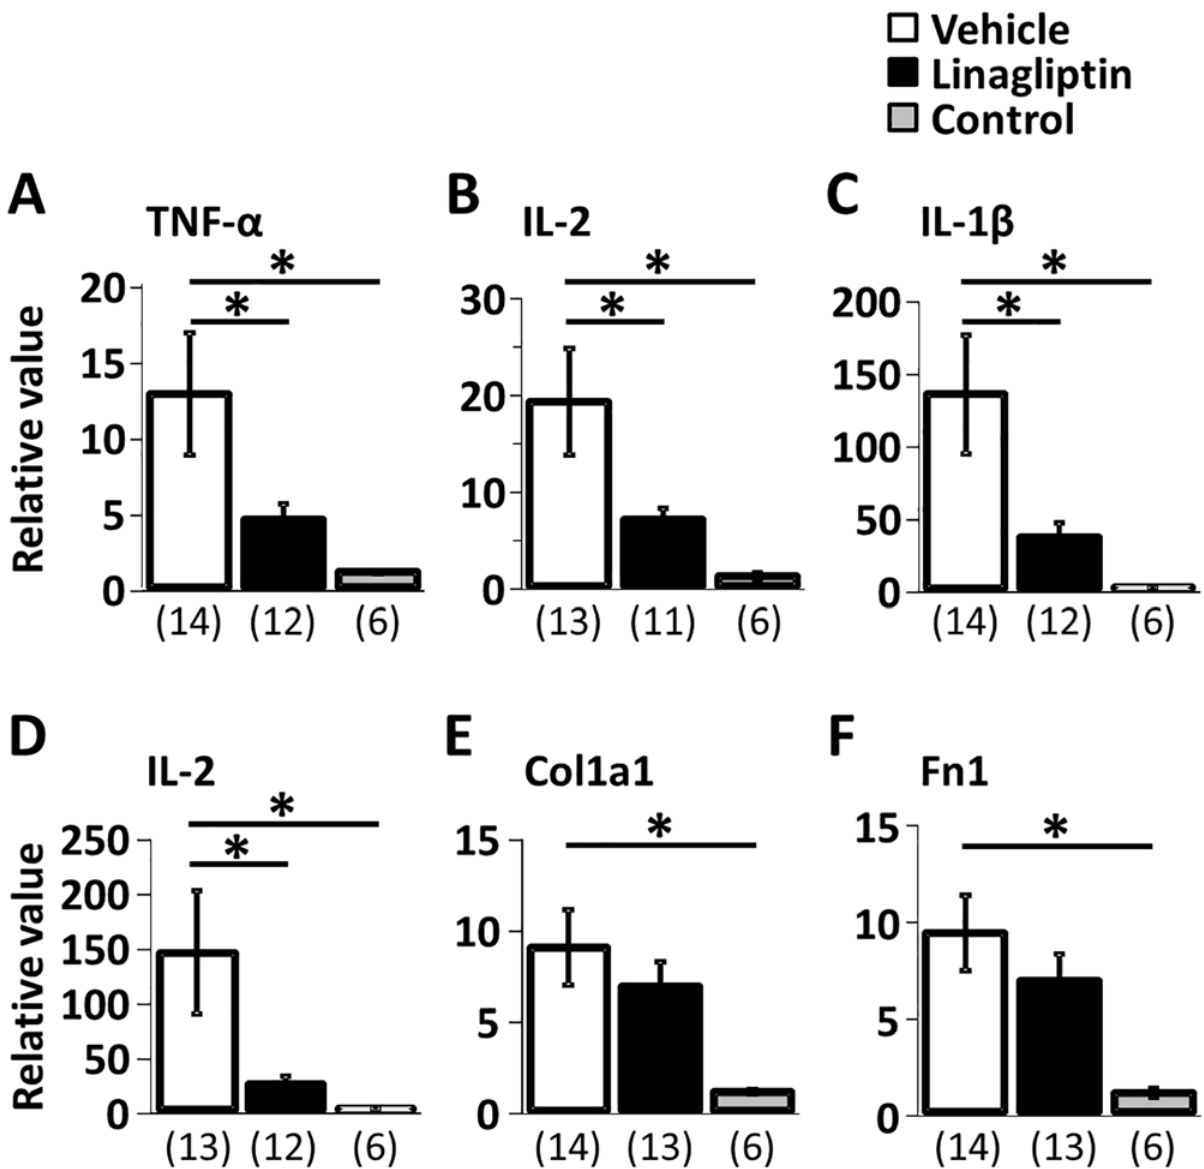
Fig 2. Results of Quantitative PCR analysis. mRNA expression of TNF- α (A), IL-2 (B), IL-1 β (C), IL-6 (D), Col-1a1 (E) and Fn-1(F) in the hearts on day 21. * P < 0.05, Fisher ’ s PLSD. Values are mean ± SEM.